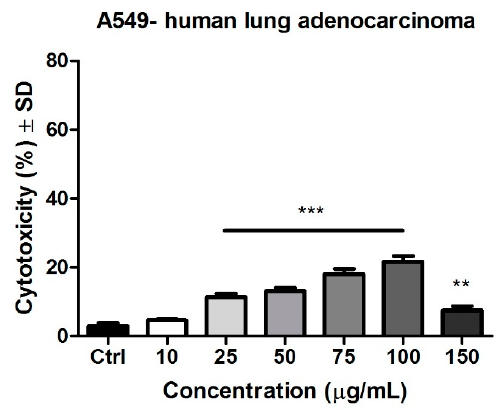
Figure 10. Pg (10, 25, 50, 75, 100, and 150 µg/mL) cytotoxic effect on A549 human lung adenocarci- noma cells after 72 h stimulation. The data are expressed as cytotoxicity percentage (%) related to the control cells. One-way ANOVA test and Dunnett’s multiple comparison post-test were employed for comparison among groups (** p < 0.01, *** p < 0.001 vs. Control).